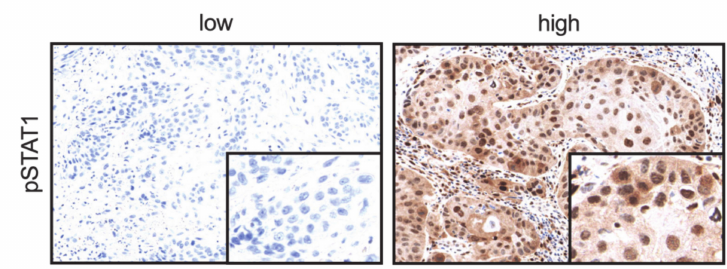
Figure 5. Representative images show IHC on pSTAT1 negative and high-pSTAT1-expressing HNSCC primary